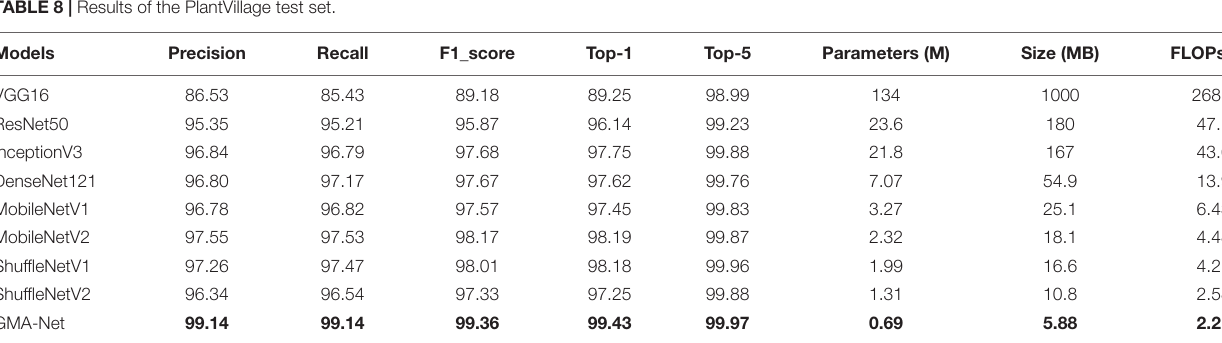
TABLE 8 | Results of the PlantVillage test